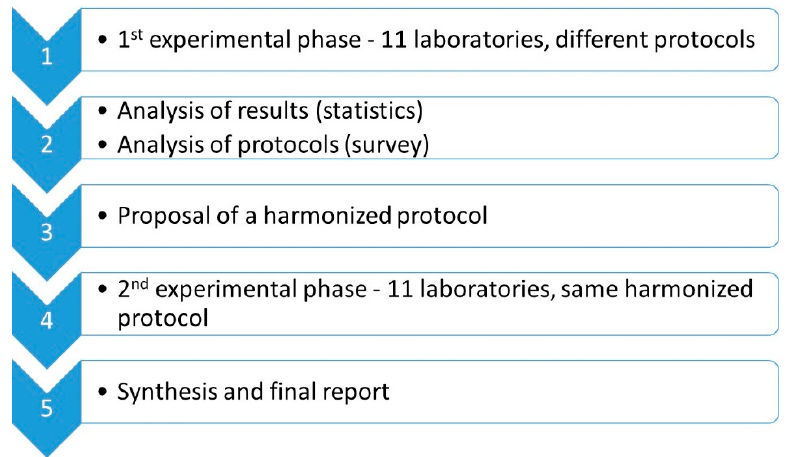
Figure 1. Schedule of the methodology applied during this inter-laboratory study.